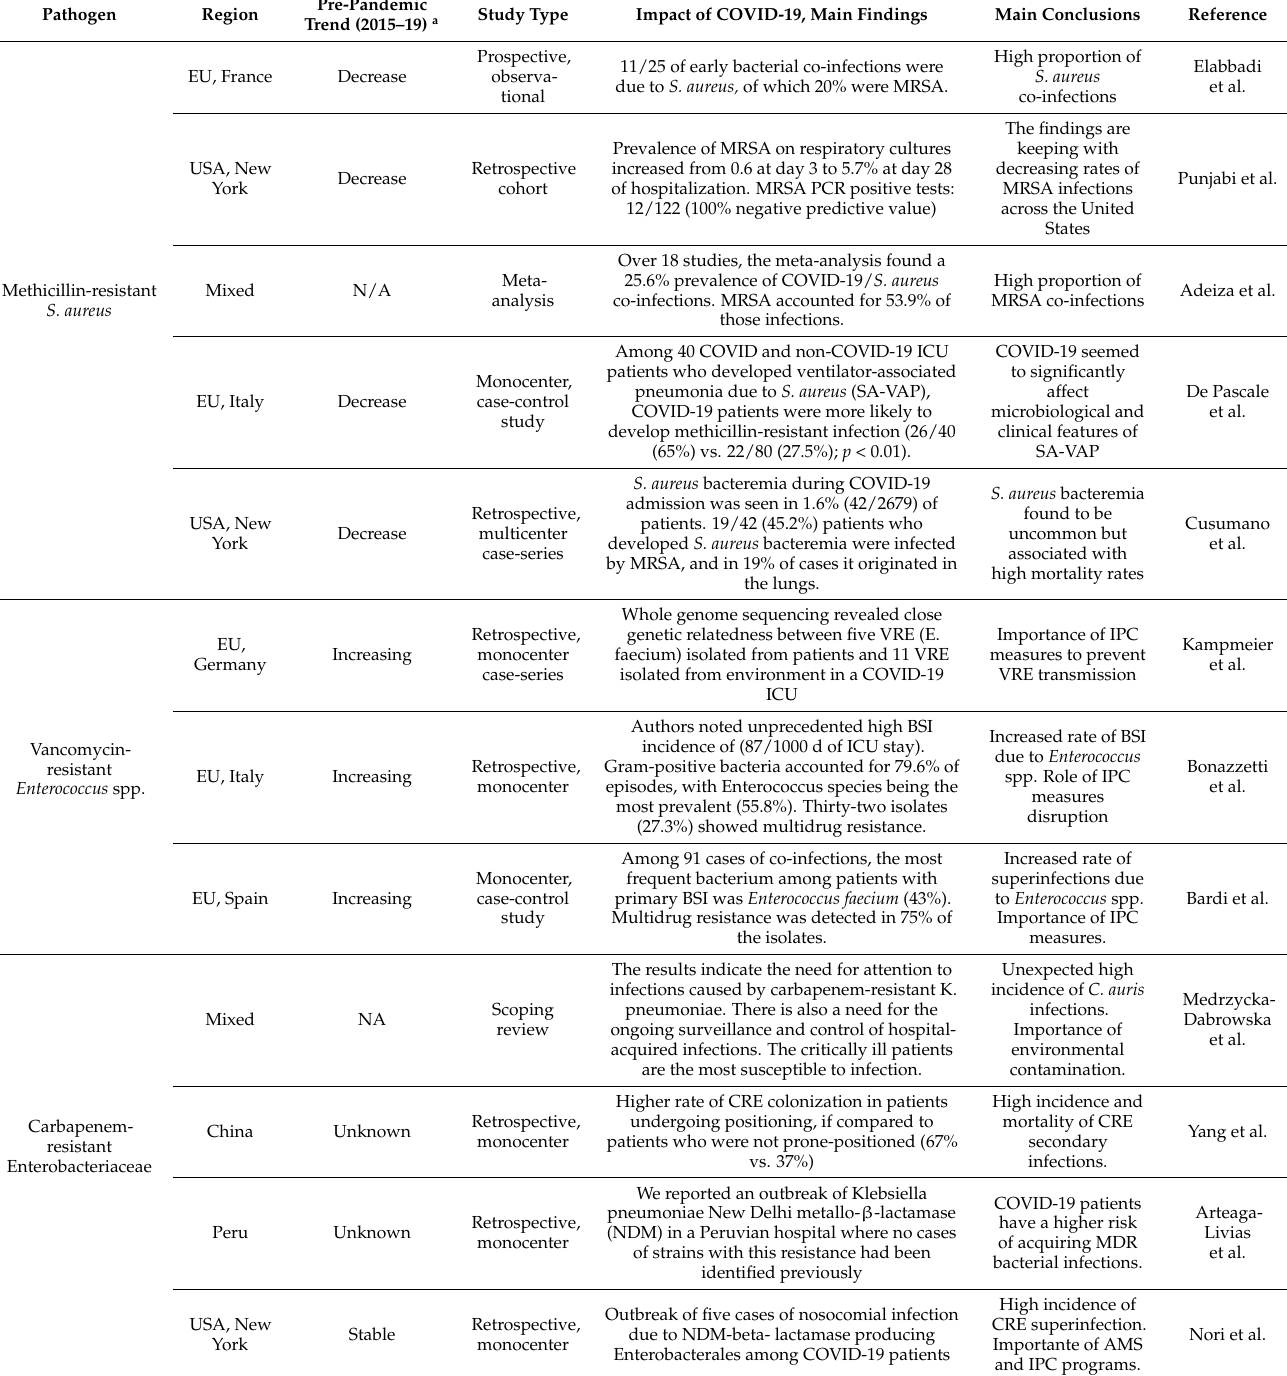
Table 1. Summary of the main